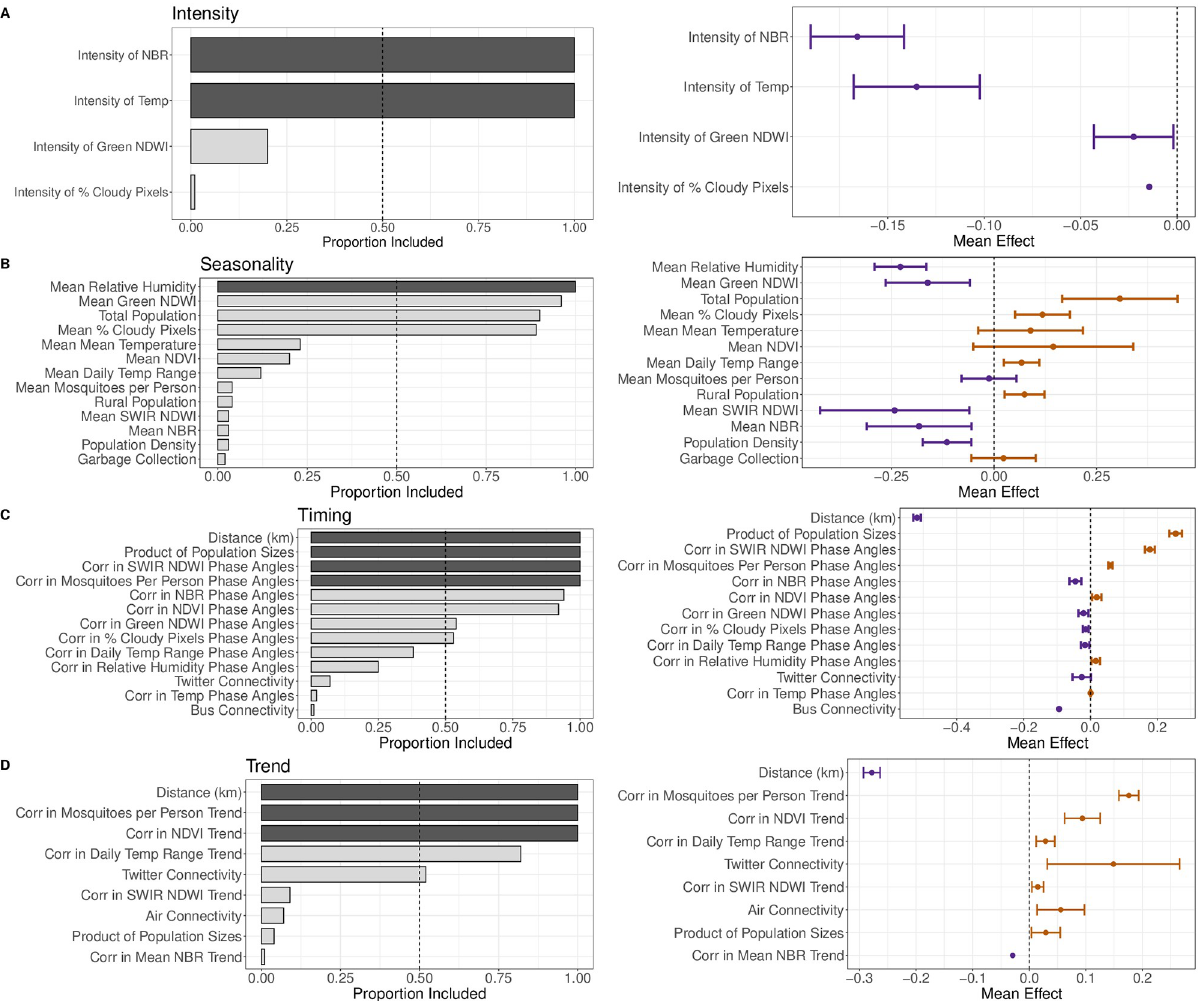
Fig 5. Coefficients of the best-performing outbreak property models. ( Left ) Covariates are ordered by the proportion of times they were included in the final model. Dark bars indicate a covariate was included in all 100 of the LASSO fits. ( Right ) The mean and standard deviation coefficient when the covariate was included in the model. Orange bars indicate a positive effect on the outbreak property value; purple bars indicate a negative effect on the outbreak property